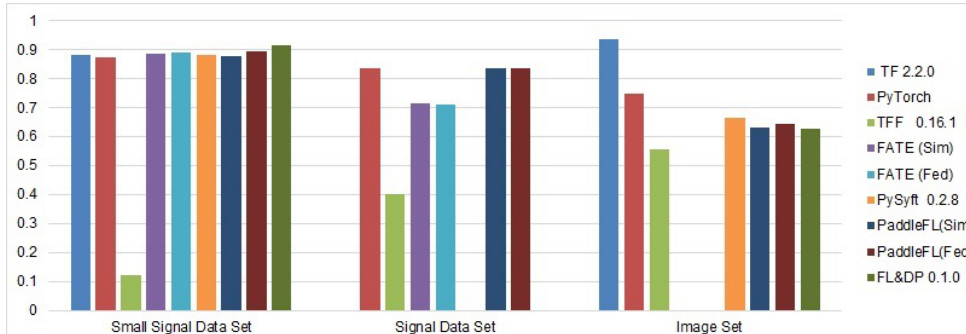
Figure 9. Accuracy of the FL frameworks.